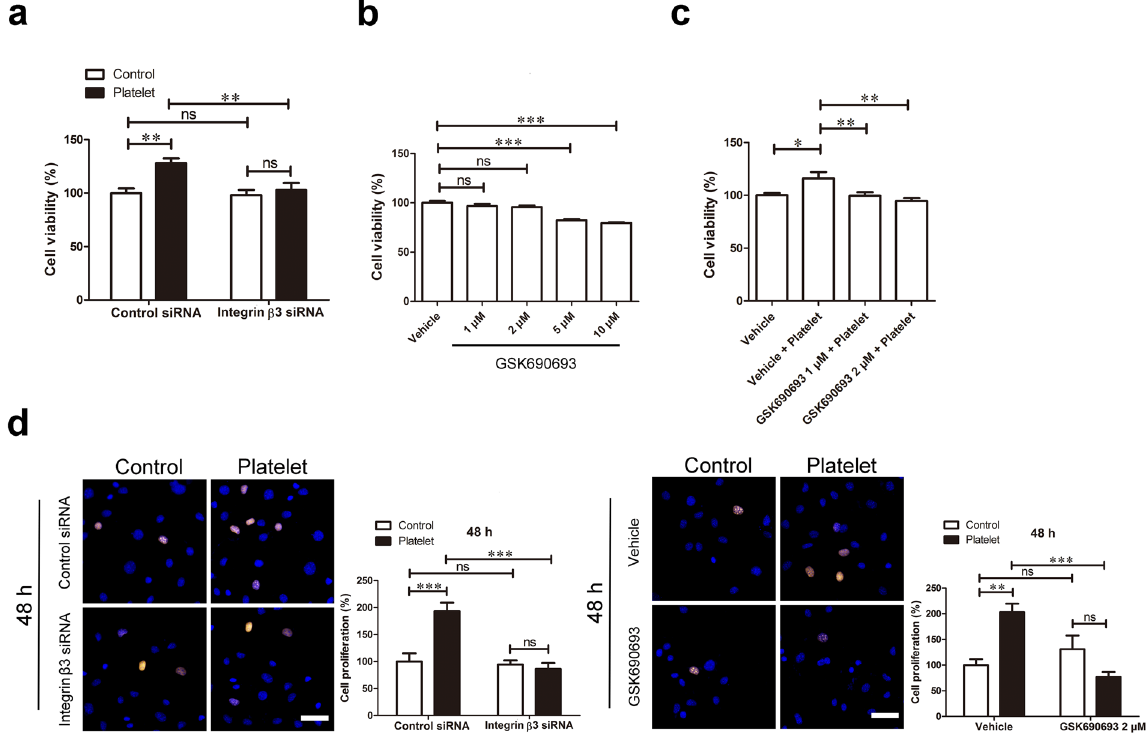
Figure 6. The integrin β 3/Akt signaling contributed to platelet-induced EOMA cell proliferation. ( a ) EOMA cells were transfected with control or integrin β 3 siRNA for 4 days, and then treated with platelets for another 72 hours. The cell viability was examined using the CCK8 assay. ( b ) The EOMA cells were incubated with indicated concentrations of Akt inhibitor GSK690693 for 72 hours. GSK690693 treatments with 1 and 2 μ M did not significantly affect EOMA cell survival. ( c ) EOMA cells were pre-treated with Akt inhibitor GSK690693 for 3 hours, and then incubated with platelets for another 72 hours. The cell viability was examined using the CCK8 assay. ( d ) EOMA cells were either transfected with control or integrin β 3 siRNA for 4 days, or pre-treated with GSK690693 for 3 hours, and then incubated with platelets for another 48 hours. The cell proliferation was assessed via the EdU assay. Scale bar, 60 μ m. n = 3–5, one-way or two-way ANOVA. * P < 0.05; ** P < 0.01; *** P < 0.001; ns, not